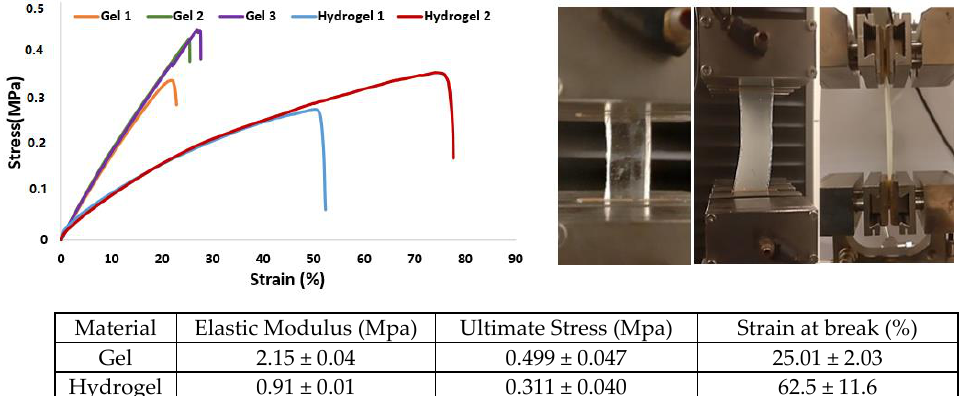
Figure 6. Mechanical analysis results of urazole-potassium hydrogels and semicarbazide gels.